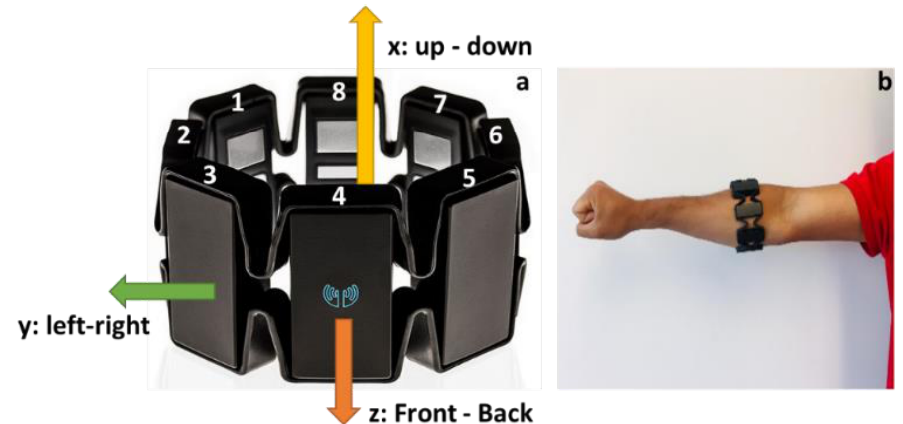
Figure 1. ( a ) Myo armband electrode location and ( b ) Myo armband placement on the forearm.